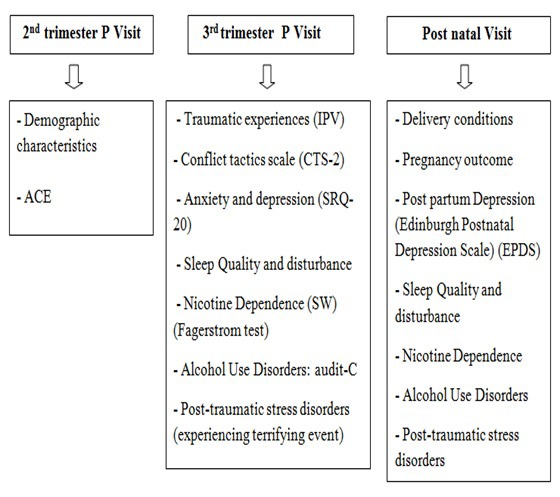
The schedule of the visits performed by the midwives.